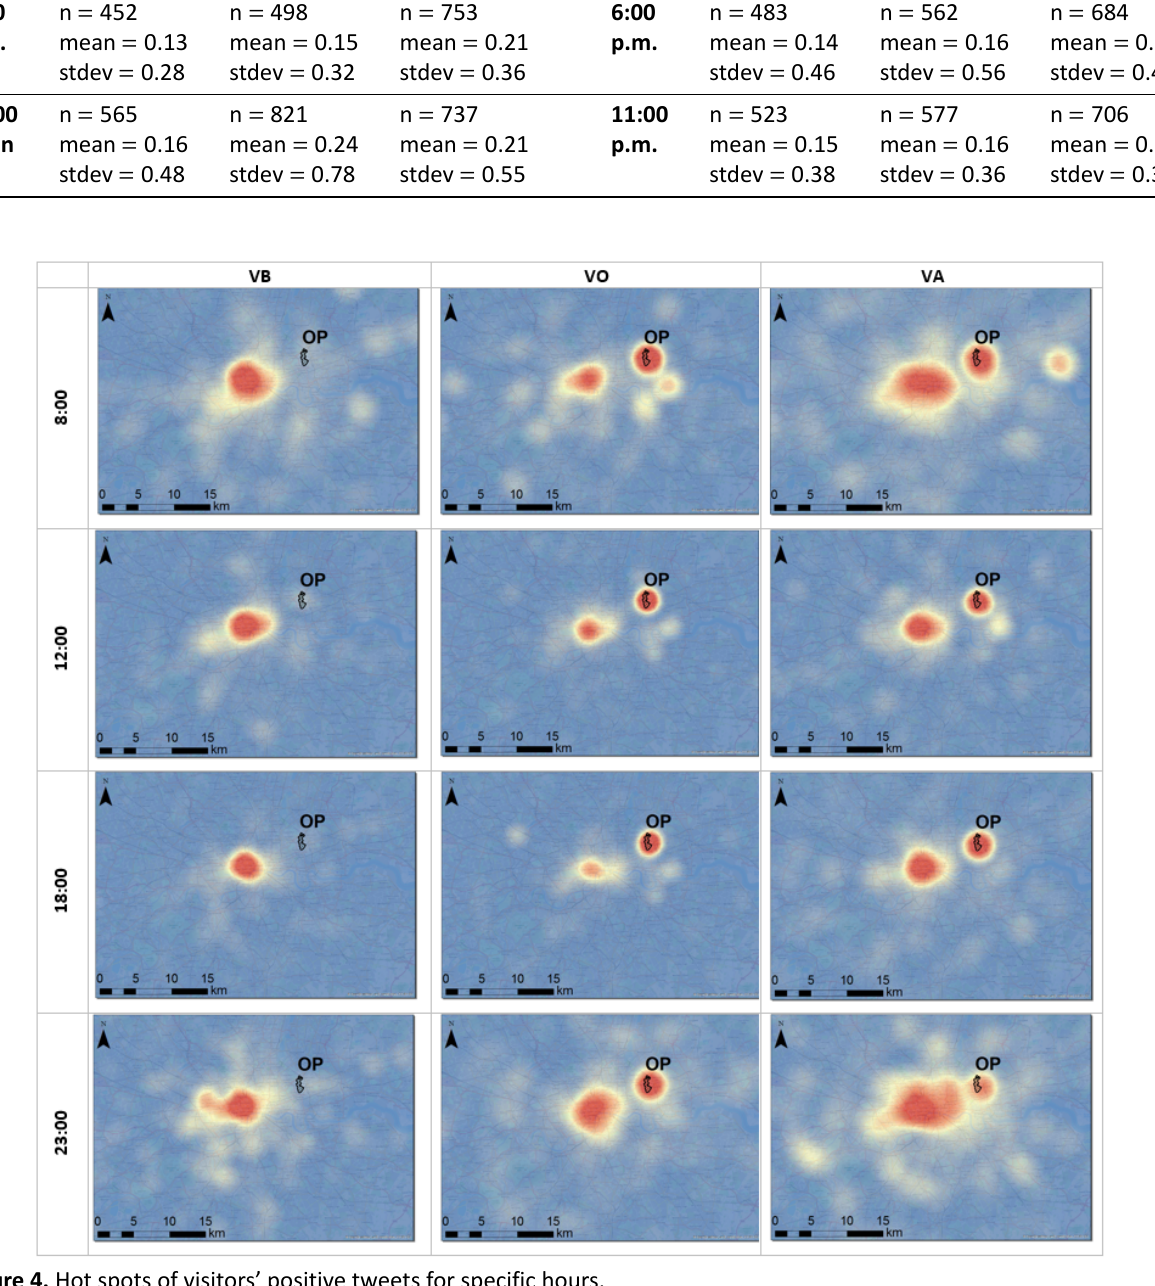
Figure 4. Hot spots of visitors’ positive tweets for specific